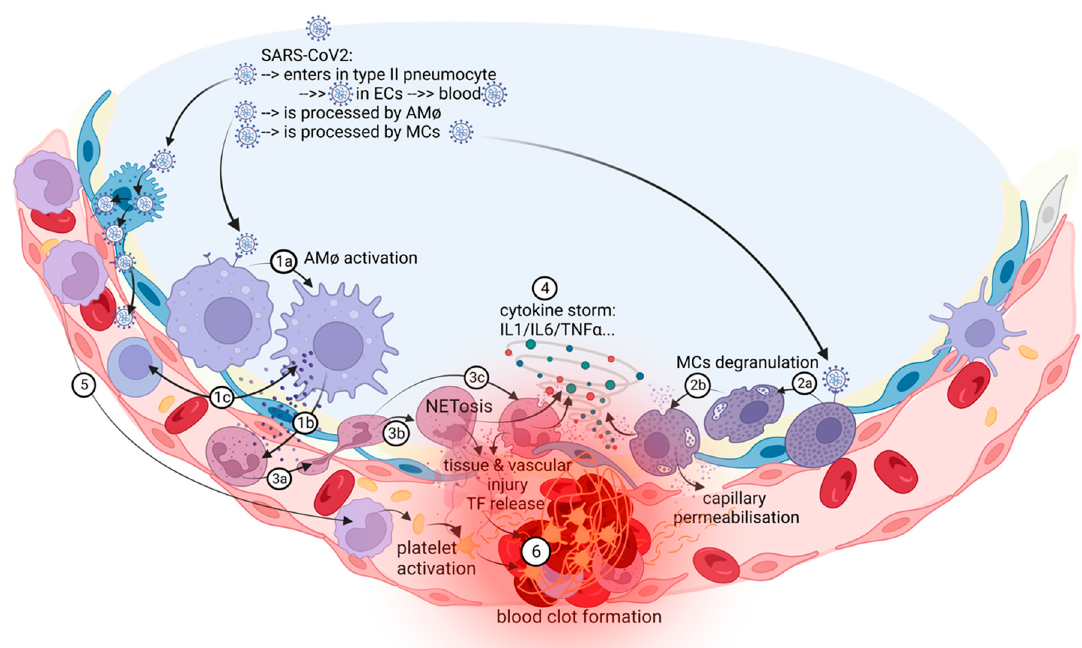
Figure 2 . The in situ immunothrombosis in COVID-19. SARS-CoV-2 replicates into pneumocytes. Furthermore, SARS-CoV-2 could be transferred to adjacent ECs that have ACE-2 receptors and passed into the blood. AM ϕ s interact with SARS-CoV-2 and activate themselves (1a). After activation, the major process in COVID-19 is the chemoattraction of neutrophils (1b). AM ϕ s could also act like antigen presenters to T lymphocytes (1c). Neutrophils, attracted by AM ϕ s, come into the area of the immune conflict, crawling, and squeezing (3a), and they activate and release neutrophil extracellular traps (NETosis) (3b); aberrant NETosis and oxidants released (3c) into the environment contribute to “cytokine storm” (4), tissue and vascular injuries and initiate immune-activated coagulation (6). SARS-CoV-2 activates MCs (2a) and they release histamine, other specific proteases, prostaglandins and leukotrienes, cytokines and chemokines (2b), contributing to capillary permeabilization and to the “cytokine storm” (4), ending with in situ immunothrombosis (6). Monocytes are excessively recruited in the area (5) and contribute to the “cytokine storm” (4)